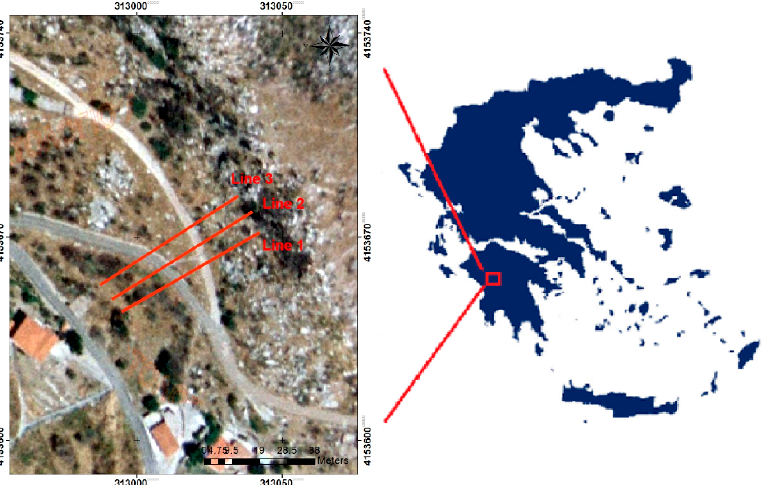
Figure 4. Slope profiles used in RocFall analysis regarding Myloi region. The slope picture is taken from Greek Cadastral (2008). Table 3. Geological and material characteristics.